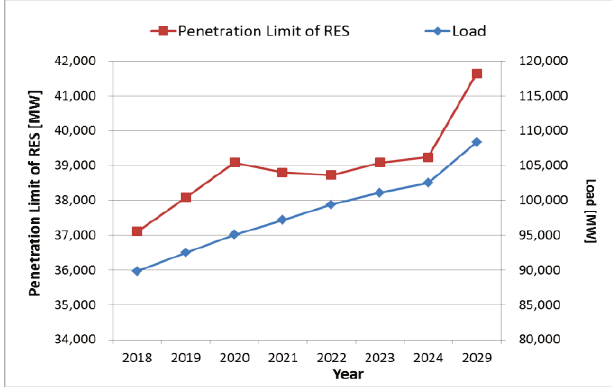
Figure 5. Penetration limit of RES calculated using the minimum generation of conventional sources.